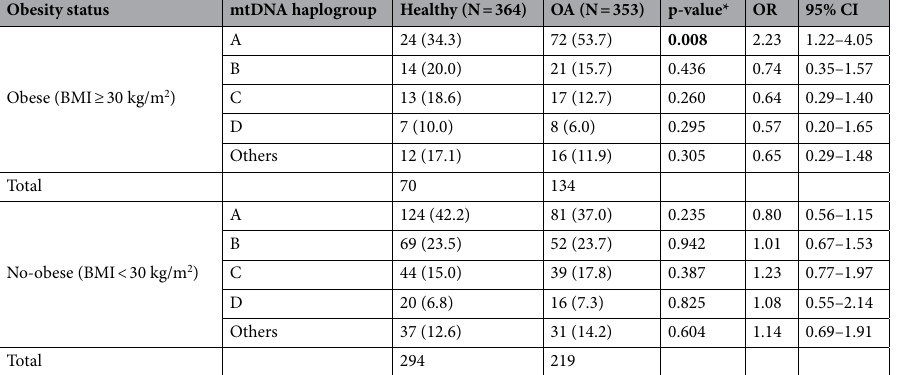
Table 4. Frequency distribution of American mtDNA haplogroups between osteoarthritic patients and healthy controls stratified by their obesity status. Values are number of patients with percentage in parentheses. BMI body mass index, OR odds ratio, CI confidence interval. *Statistical significance declared at p ≤ 0.01 (in bold) after Bonferroni correction.